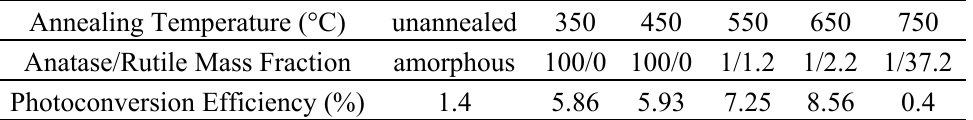
Table 5. Data from [44] on the photoconversion efficiency of un-sensitized titania nanotubes annealed at different temperatures in an oxygen atmosphere and illuminated under UV light. All of the samples were fabricated at 30 V for 3 h in 0.27 M NH 50 vol % glycerol in water.